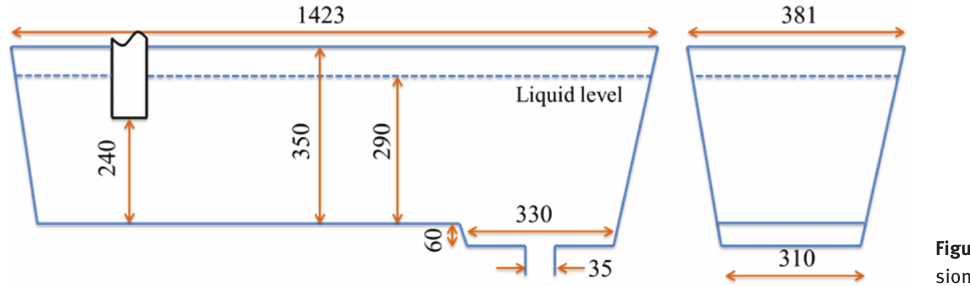
Figure 2: Schemes and dimen- sions of a